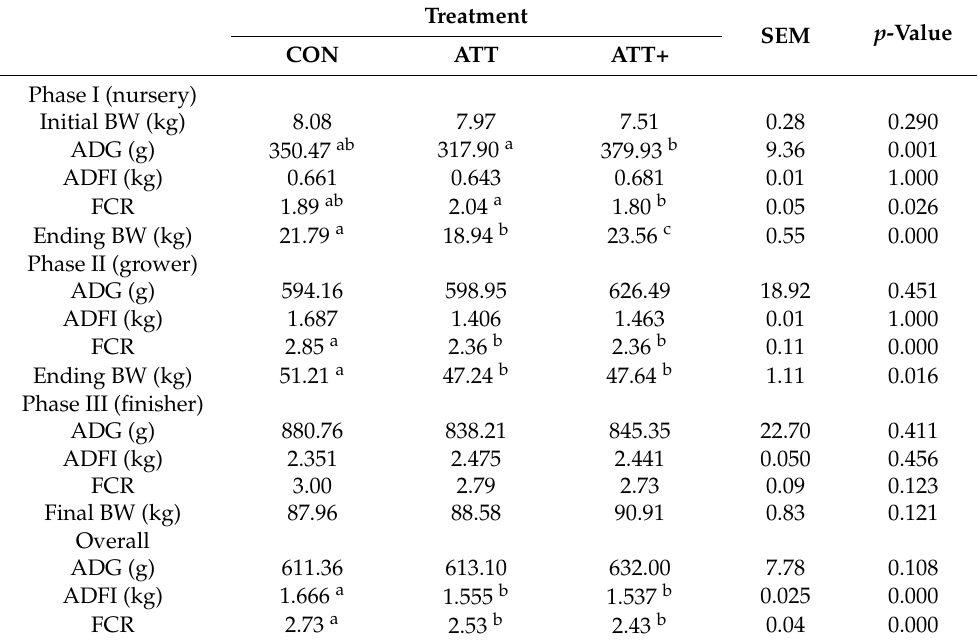
Table 2. The effect of the treatment on the growth performance characteristics of pigs in Farm A ( n = 8/treatment). Treatment SEM p -Value CON ATT ATT+ Phase I (nursery) 8.08 7.97